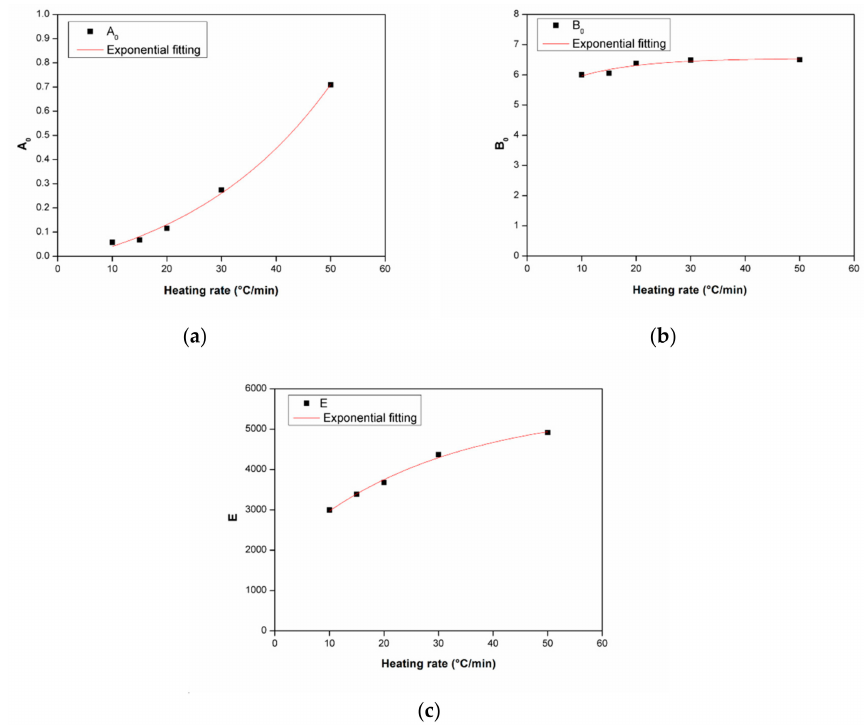
Figure 12. Kinetic parameters A 0 ( a ), B 0 ( b ), and E ( c ) for polymerization of ε -caprolactam at di ff erent heating rates.